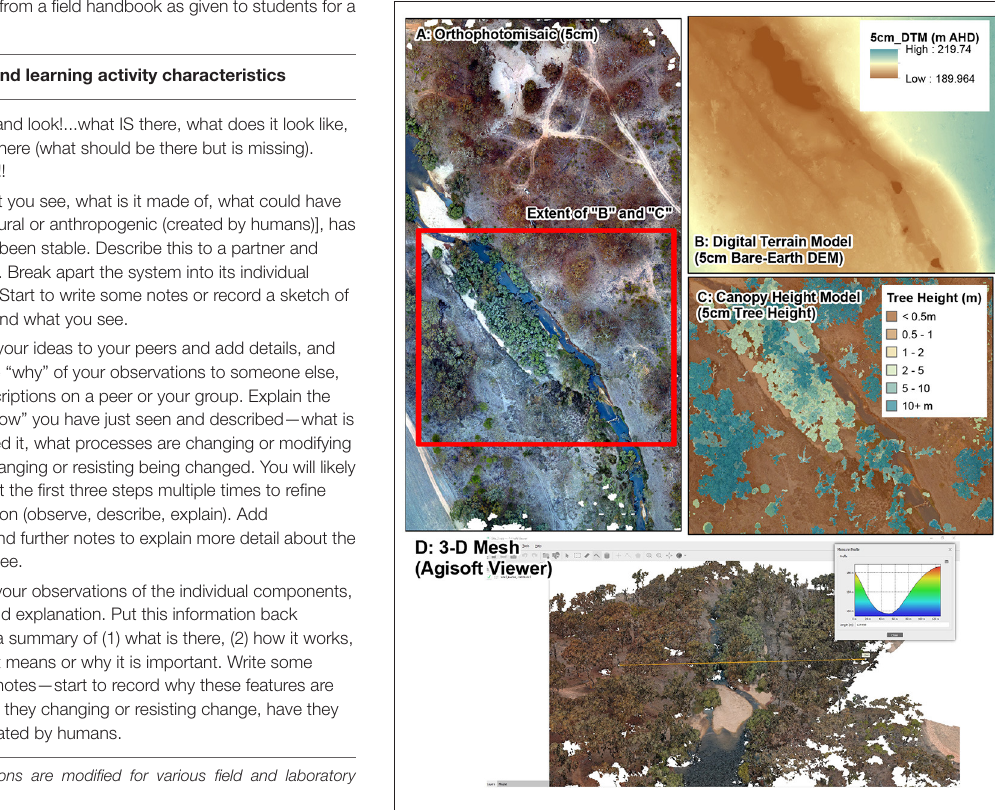
FIGURE 4 | Example of digital field sites constructed from drone photogrammetry to create various types of digital field data in-lieu of field data collection, including: (A) A 5 cm high-resolution digital orthophotomosaic of the field site; (B) A Digital Terrain Model (DTM) or bare-earth Digital Elevation Model (DEM) of elevation; (C) Canopy Height Model of tree height; (D) 3-D scene as viewed in Agisoft